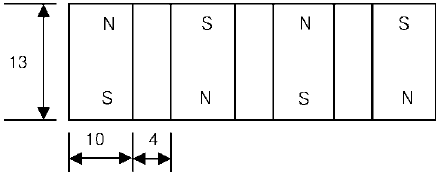
Figure 16 Type B structure for the second application.